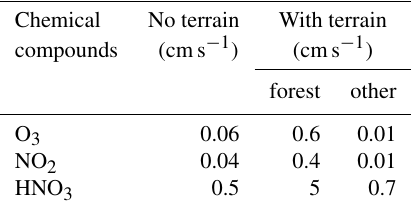
Table 3. Dry deposition velocity used in this